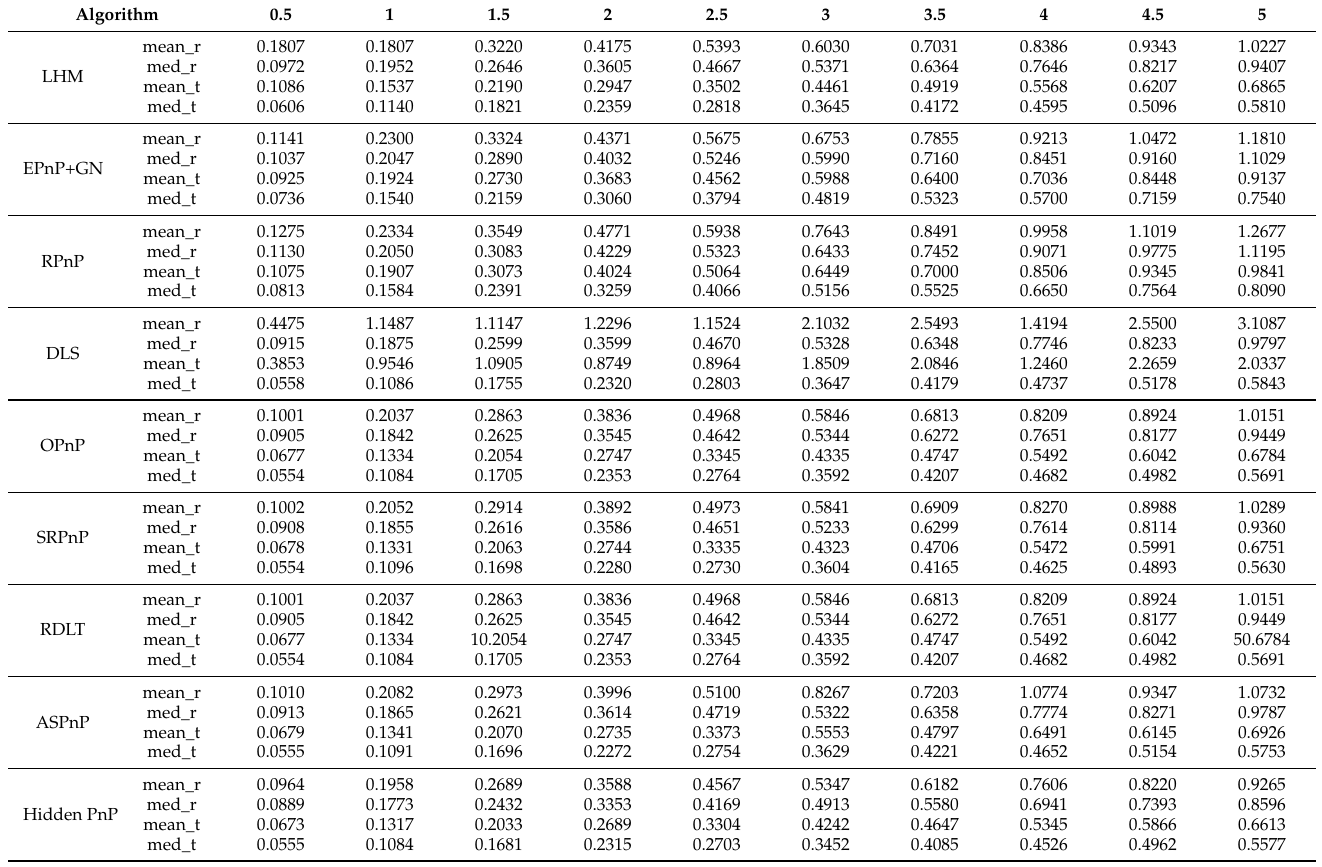
Table A4. Error comparison in ordinary 3D case.